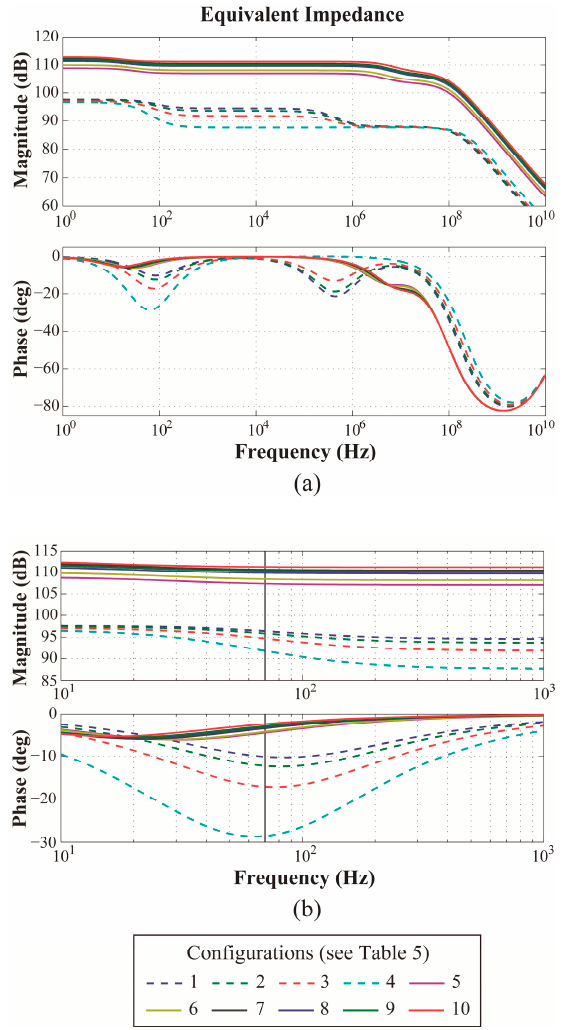
Figure 7. Bioimpedance of neointima for the histological configurations in Table 5: ( a ) large Bode plot, and ( b ) detailed plot at around 70 Hz.